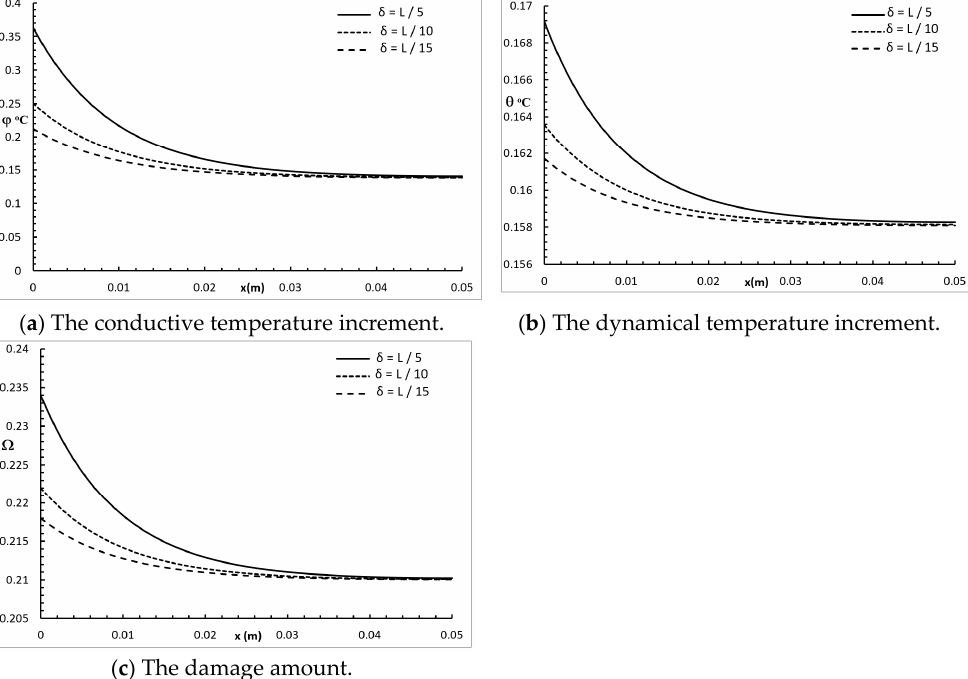
Polymers 2019 , 11 , x FOR PEER REVIEW